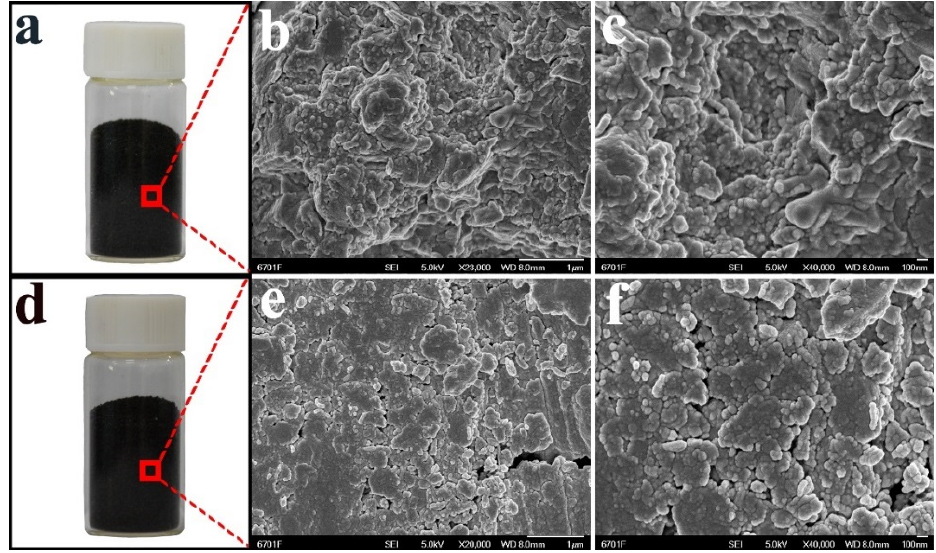
Figure 3. Digital photo of PAMS ( a ) and PAMFS ( d ), SEM micrographs of PAMS ( b , c ) and PAMFS ( e , f ).